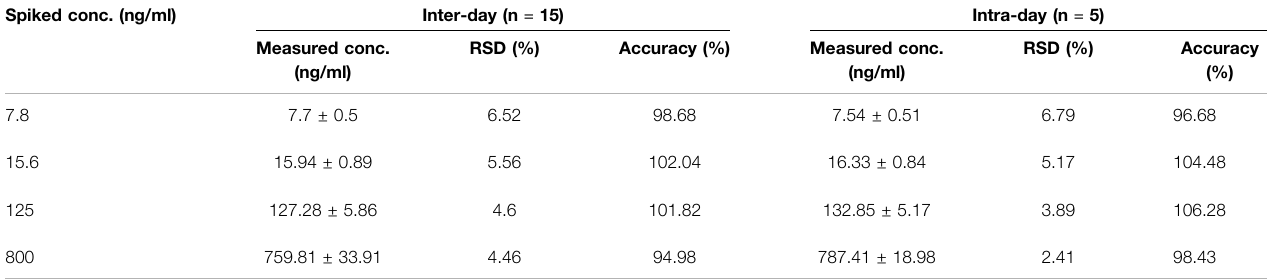
TABLE 1 | The intra- and inter-day precision and accuracy of analytes (3 days, fi ve replicates per-day). Spiked conc. (ng/ml)